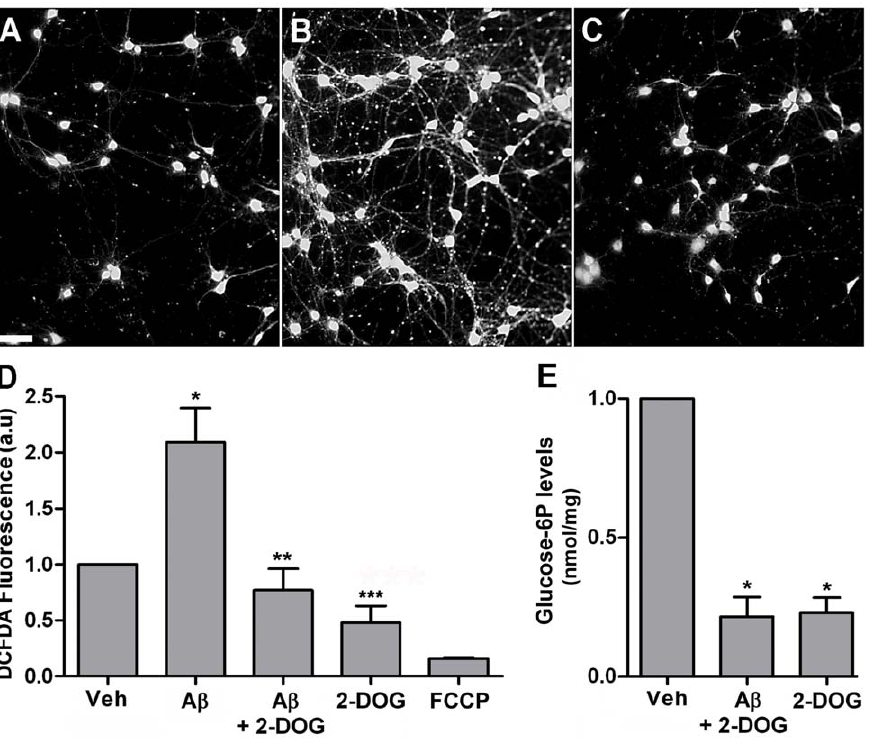
Figure 3. 2-DOG blocks A b -induced neuronal ROS formation. Representative DCF fluorescence images from control (vehicle-treated) cultures (Panel A), cultures exposed to 5 m M A b for 6 hours (Panel B) or cultures exposed to 5 m M A b + 30 mM 2-DOG for 6 hours (Panel C). When present, 2- DOG was added 10 minutes before A b . In order to allow direct comparison between ROS levels, identical conditions and exposure times for image acquisition were employed for all experimental conditions. Panel D: Quantitative analysis of DCF fluorescence from five independent experiments ( , 1,500 cells analyzed per experimental condition in each experiment) using ImageJ software (NIH Windows version). (*) indicates a statistically significant (p , 0.005) difference relative to control cultures. (**) and (***) indicates a statistically significant (p , 0.005) difference relative to A b -treated cultures. Scale bar corresponds to 100 m m. Panel E: 2-DOG decreases neuronal G6P levels in neurons exposed to A b . Glucose-6P levels were measured in control cortical neurons or neurons exposed to 5 m M A b + 30 mM 2-DOG or 30 mM 2-DOG. Values represent means 6 SD from three experiments (carried out in duplicate) using independent neuronal cultures. (*) indicates a statistically significant (p , 0.001) difference relative to control cultures.